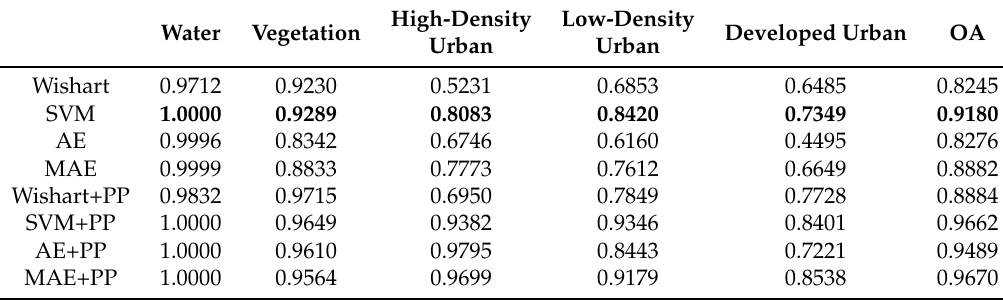
Table 10. The correct rate of each category and overall accuracy for the four comparison methods and those of the corresponding PP steps for SAN FRANCISCO BAY